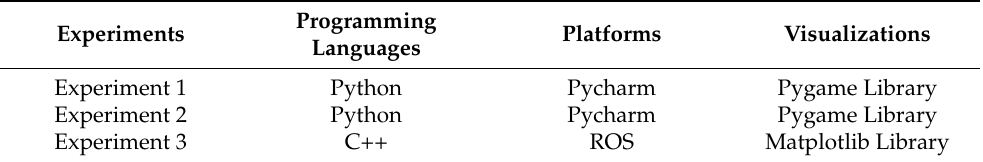
Table 6. The programming languages, platforms and visualizations used for the three